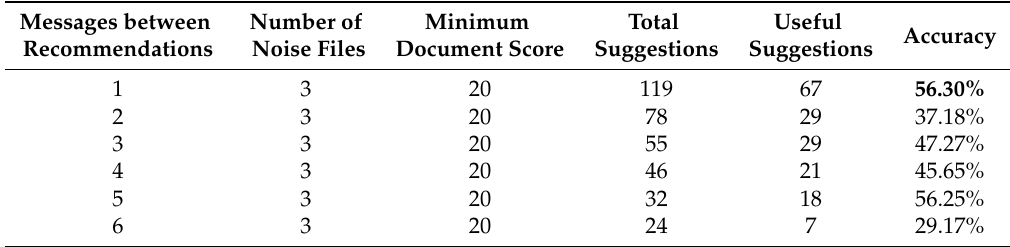
Table 3. Base approach + Noise files system – number of messages between suggestions